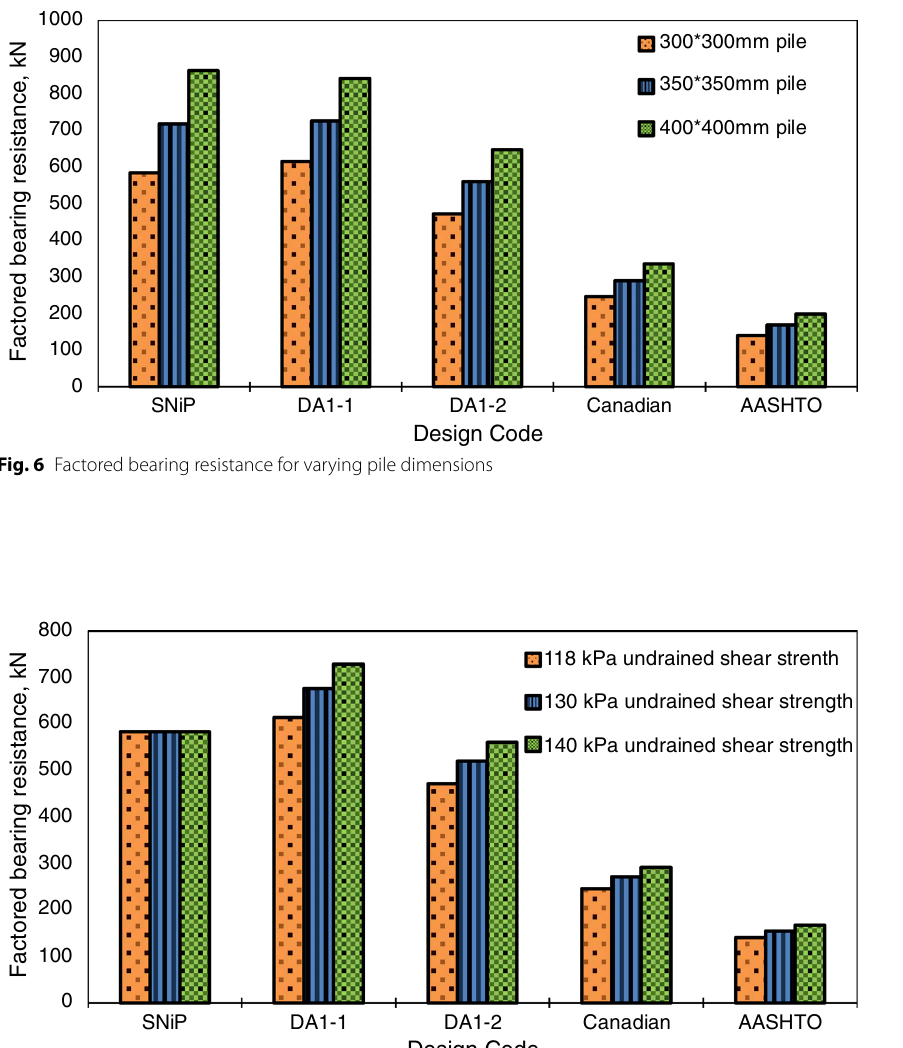
Fig. 7 Factored bearing resistance for varying undrained shear strength of